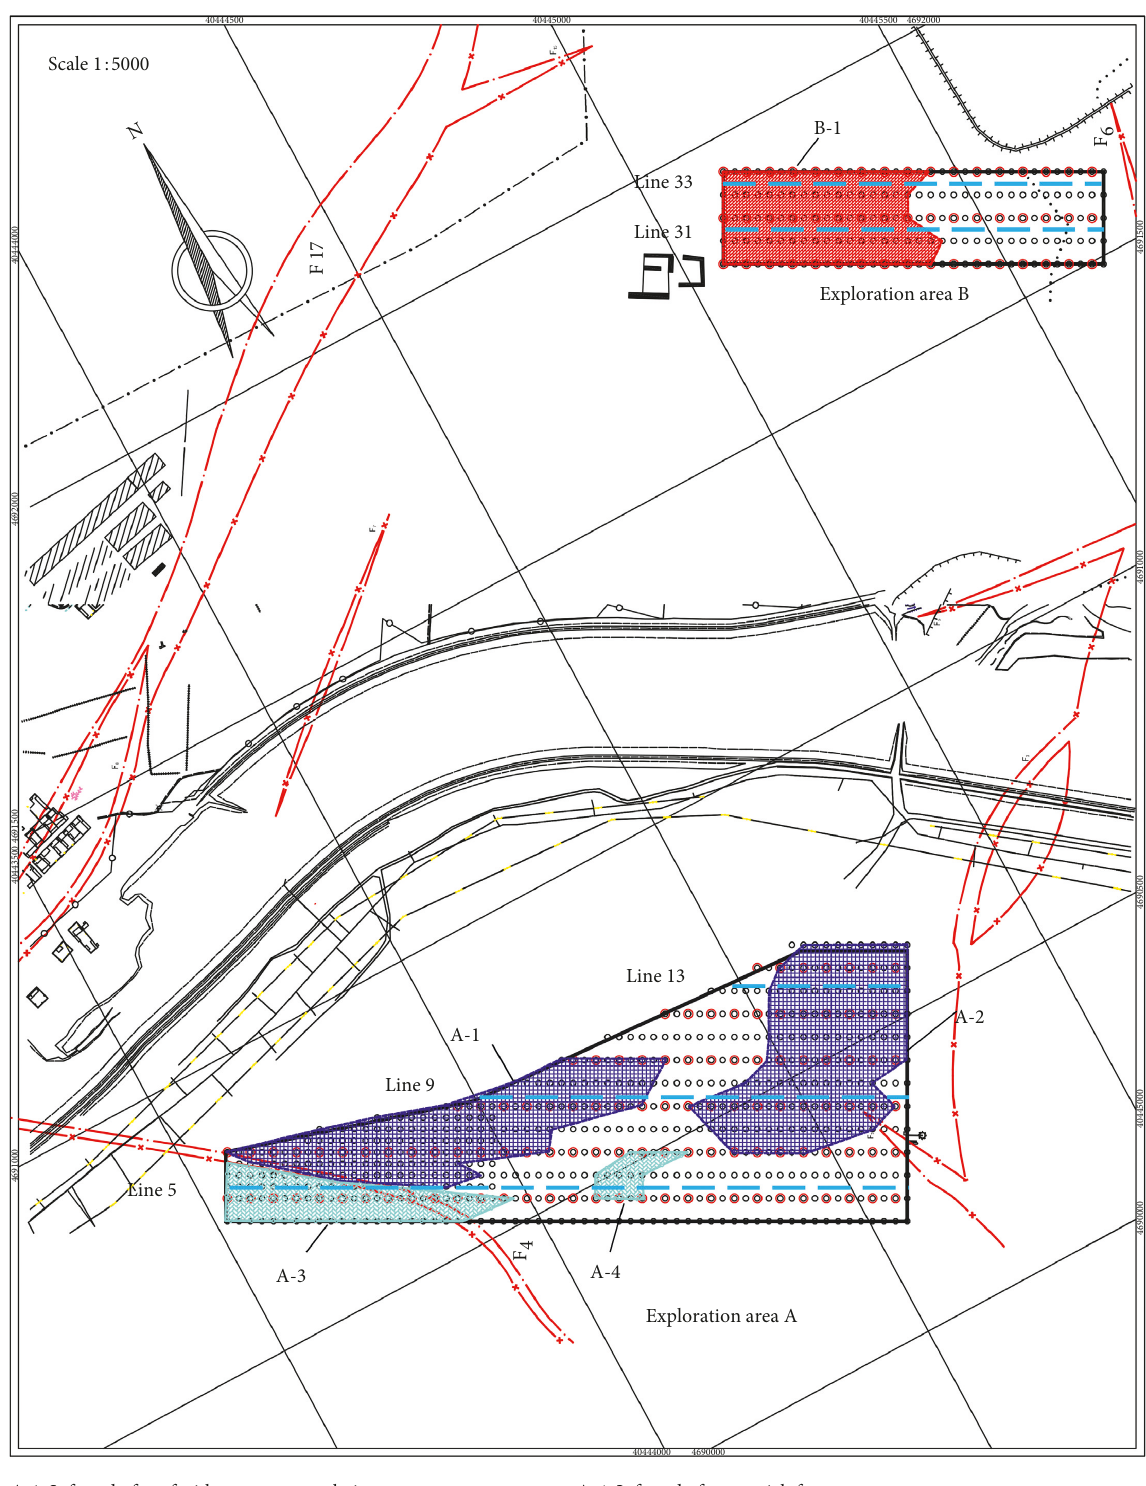
Figure 3: Zoning map of the comprehensive geophysical prospecting study